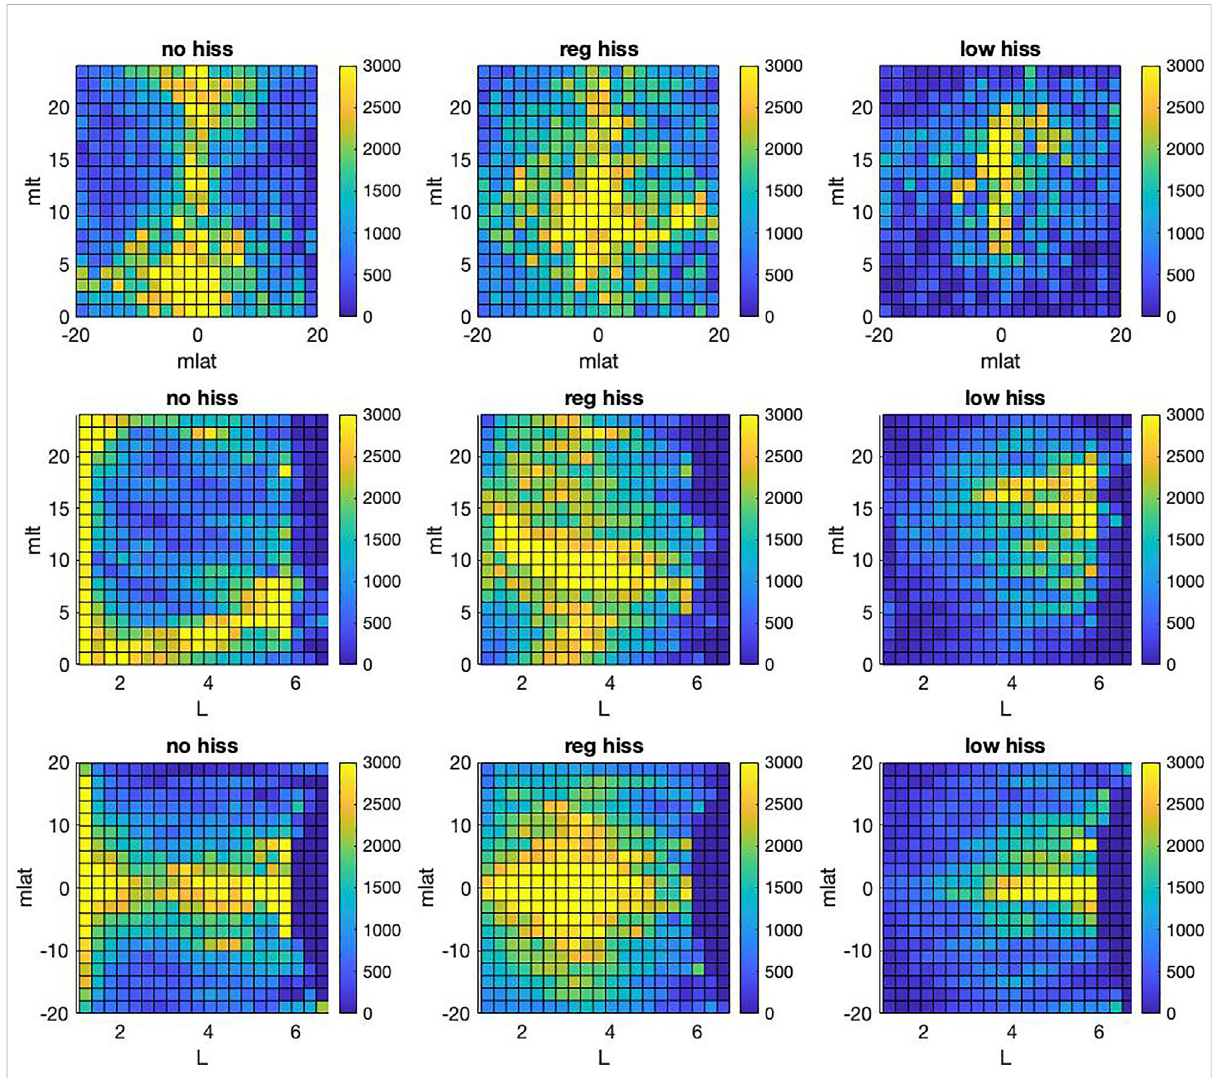
FIGURE 1 Distribution of spectral hiss classes: left column - “ no hiss ” ; center column —“ regular hiss ” ; right column - “ low frequency hiss ” ; top row — (MLT, MLAT); middle row - (MLT, L); bottom row - (MLAT, L); color bar corresponds to class membership (number count of spectral shapes) in a given